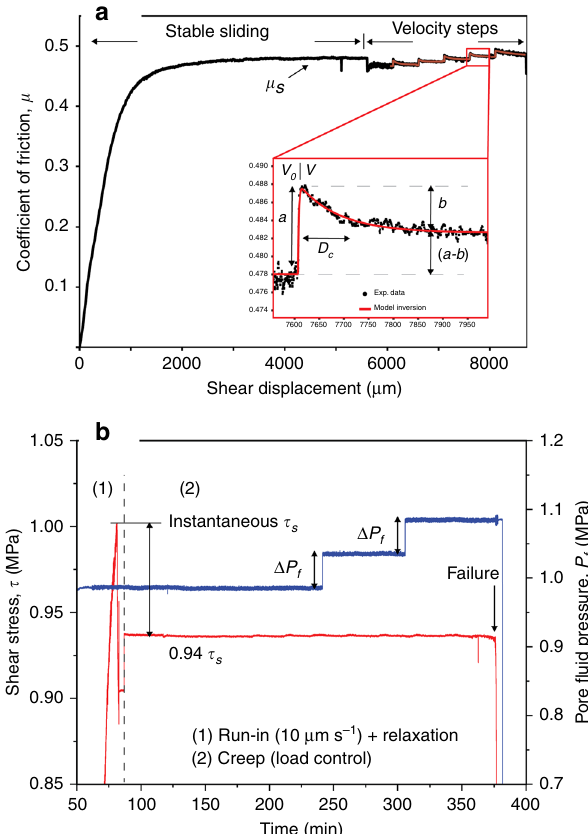
Fig. 8 Experimental procedures. a Displacement control: stable-sliding and velocity steps; b load control: creep